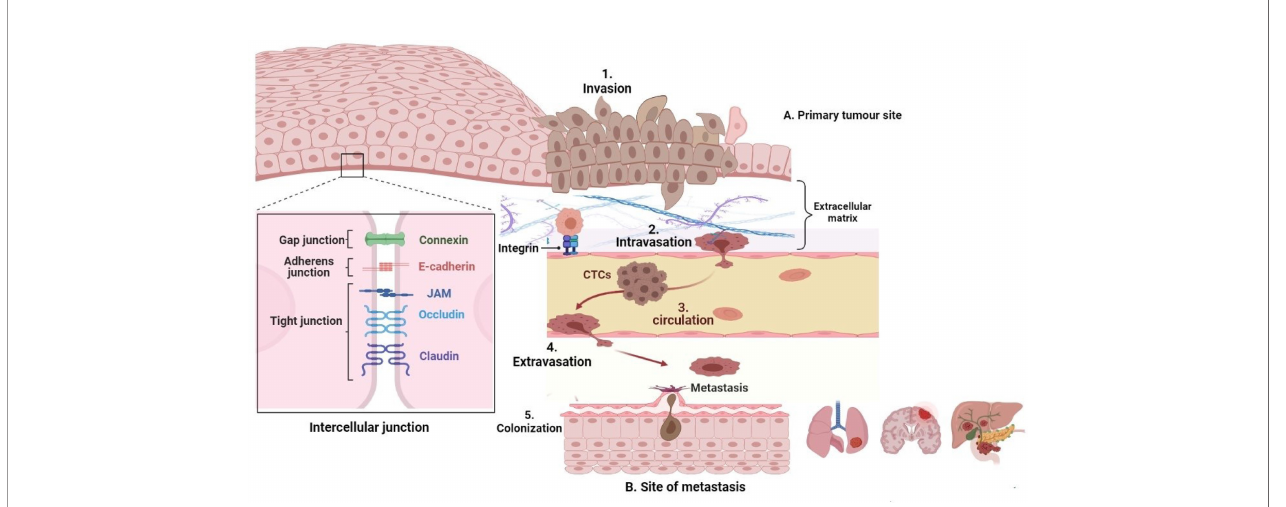
FIGURE 1 | The metastatic cascade. Epithelial tumours may sometimes undergo EMT to generate mesenchymal cells with more motile and invasive properties that penetrate the basal lamina (invasion [1]) and enter the bloodstream or lymphatic system, becoming circulating tumour cells (intravasation [2]), which are transported via the systemic circulation (circulation [3]), migrate into distant tissues that have the favourable cellular cues (extravasation [4]). The microenvironmental signals then induce an EMT reversal (also called MET) to establish secondary micrometastases (colonization